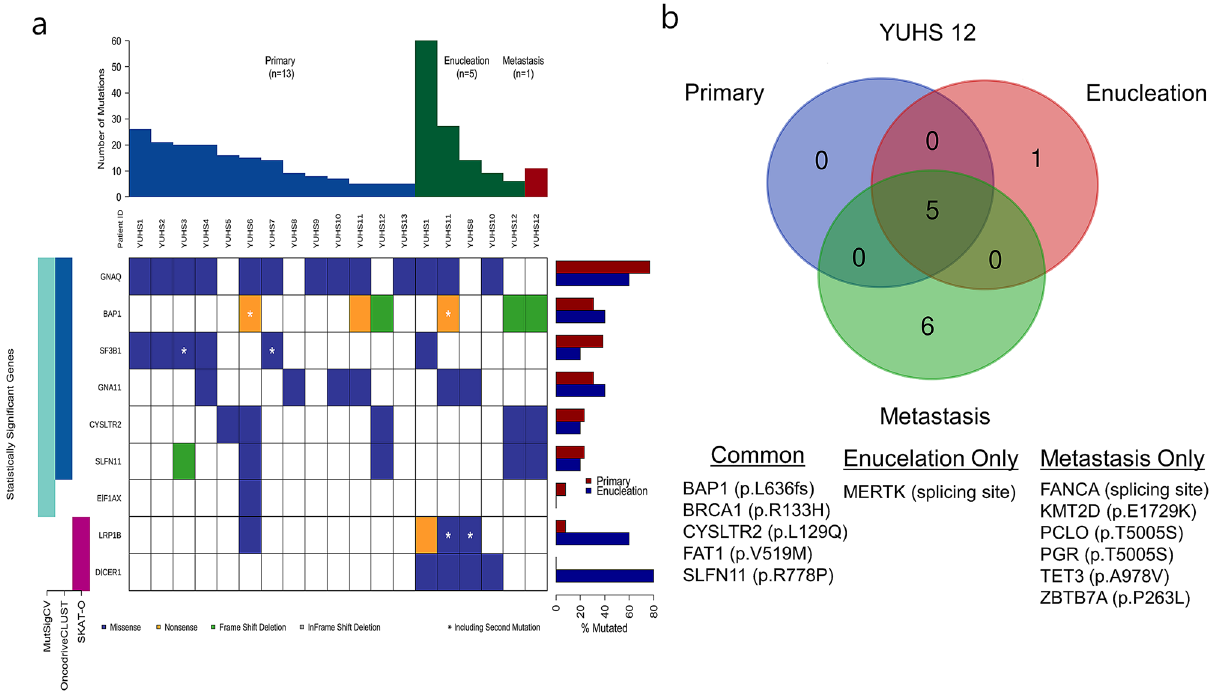
Figure 1. ( a ) Summary of Enrolled Uveal Melanoma Exome Analysis. The nonsynonymous somatic altered genes are color coded in waterfall plot. Left color coded bar indicates genes that significant in each tests such as MutSigCV, OncodriveCLUST and SKAT-O. ( b ) Comparison of somatic alterations in primary, enucleation and metastasis from YUHS 12